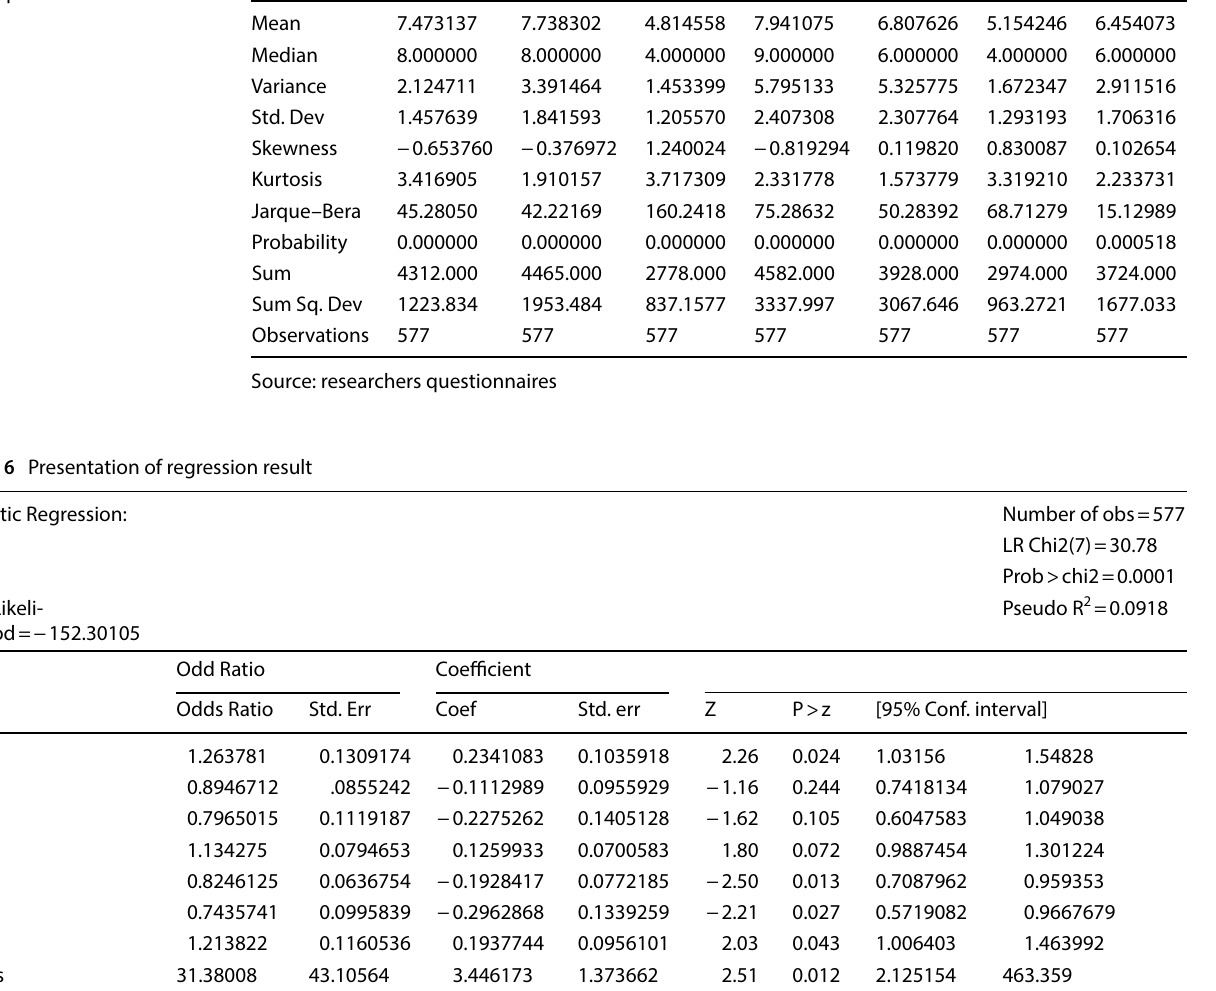
Table 5 Summary of descriptive results